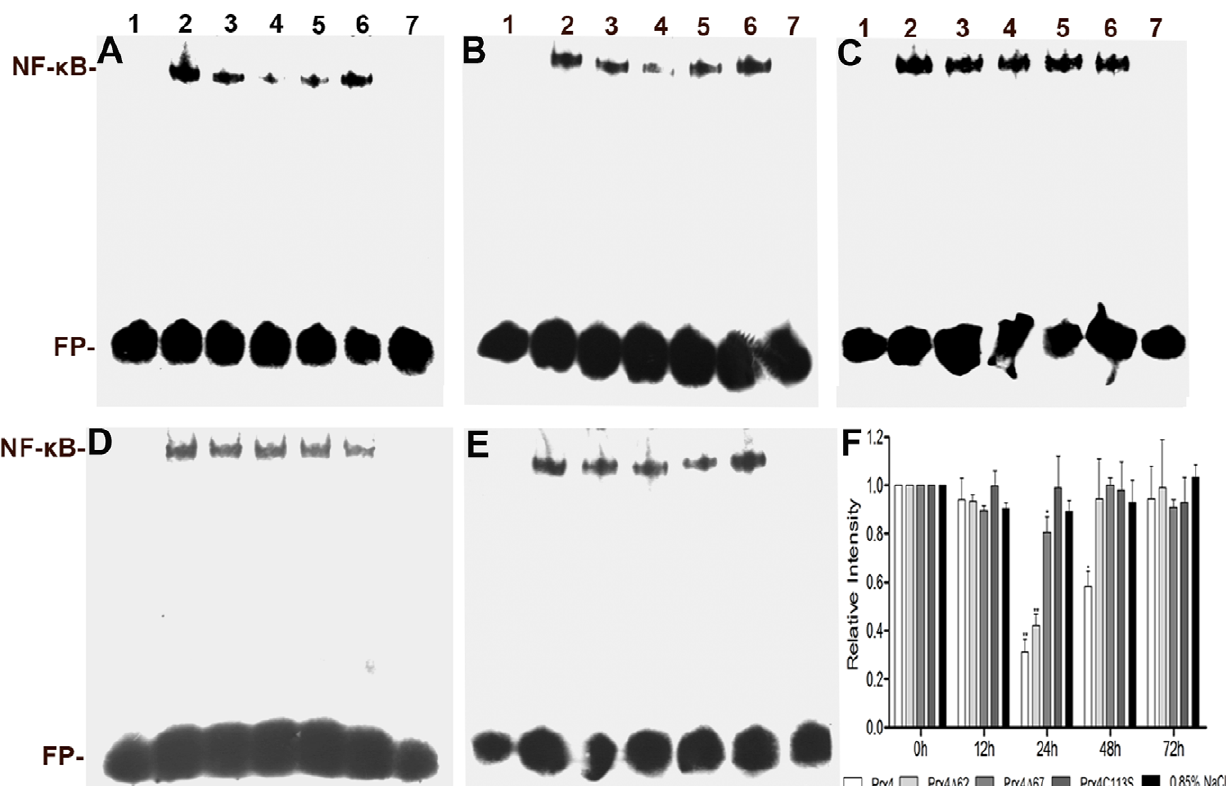
Figure 3. Effects of Prx4, Prx4 D N62, Prx4 D N67 and Prx4C113S protein on NF- k B activation. EMSA of NF- k B activity in nuclear extracts of spleen tissues from large yellow croakers injected with A Prx4, B Prx4 D N62 protein, C Prx4 D N67 protein, D Prx4C113S protein and E 0.85% NaCl (as a control). Lane 1 contains probe incubated without nuclear extracts; Lanes 2–6 contain nuclear extracts of spleen tissues collected at 0, 12, 24, 48, and 72 h post-injection; Lane 7 contains 100-fold excess of unlabeled oligonucleotide used to compete for binding. F Quantitation of relative activity of NF- k B was performed with a TANON GIS Image System Ver.3.73.